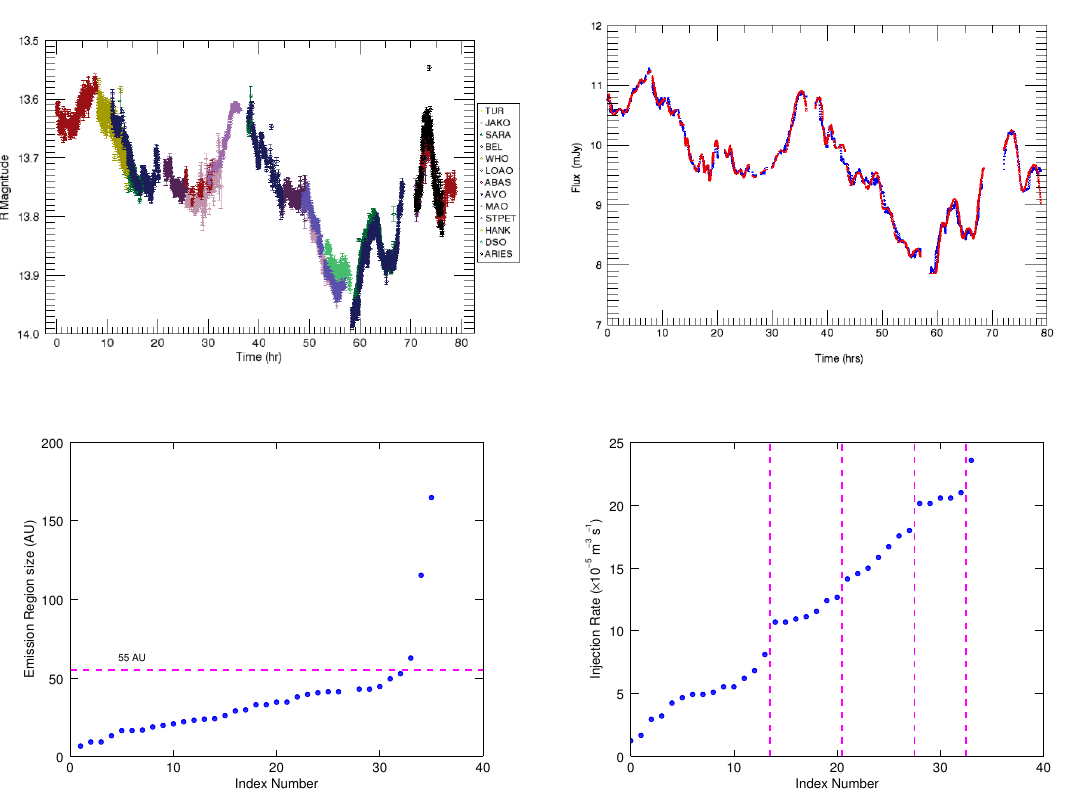
Figure 1. ( Top left ): Light curves in R band resulting from WEBT campaign in 2009. Light curves in various colors represent observations from corresponding observatories listed on the plot; ( Top right ): Smoothed light curve (blue) and model (red); ( Bottom left ): Distribution of the emission region sizes; ( Bottom right ): Distribution of the Injection rate